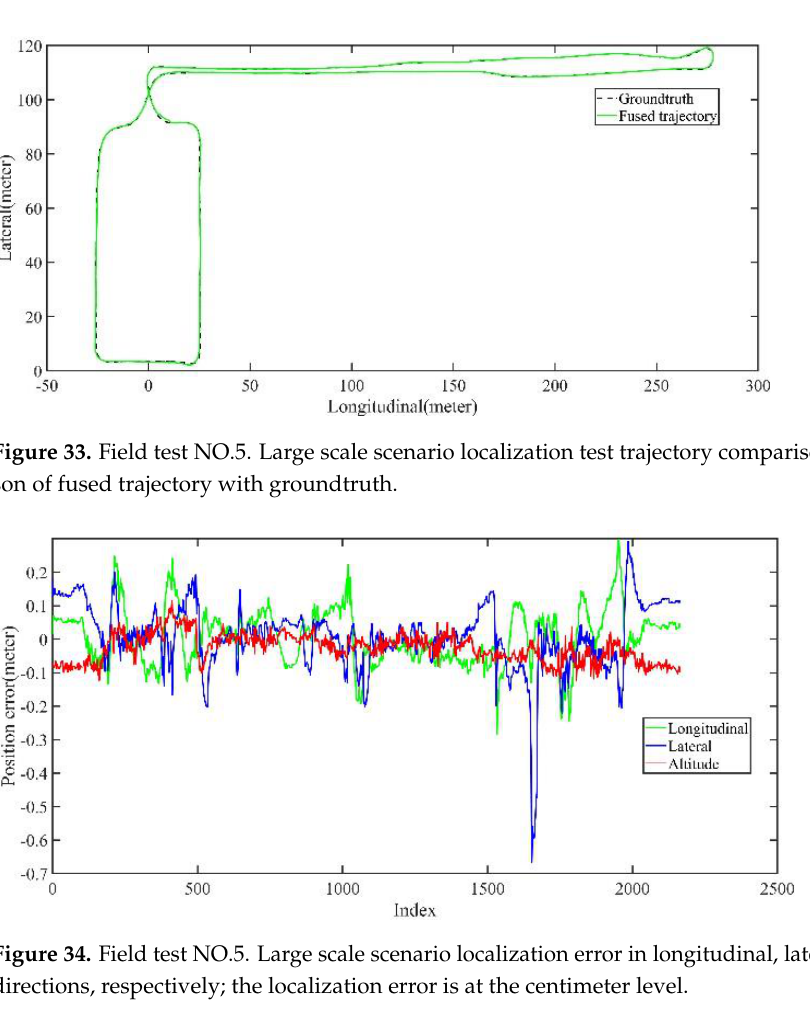
Figure 32. Field test NO.5. Large-scale scenario localization test in prior point cloud map. The white points in the figure are the point cloud map built by the offline mapping process, the red line is the trajectory of LiDAR matching results, the orange line is groundtruth, and the blue line is the fused trajectory.